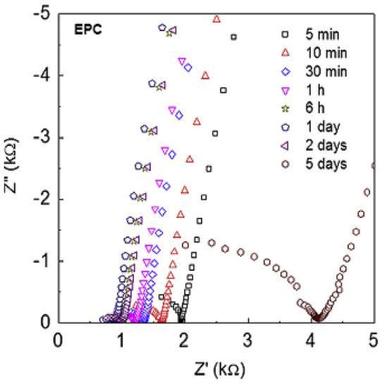
Nyquist plots of portland cement in the early hydration time.